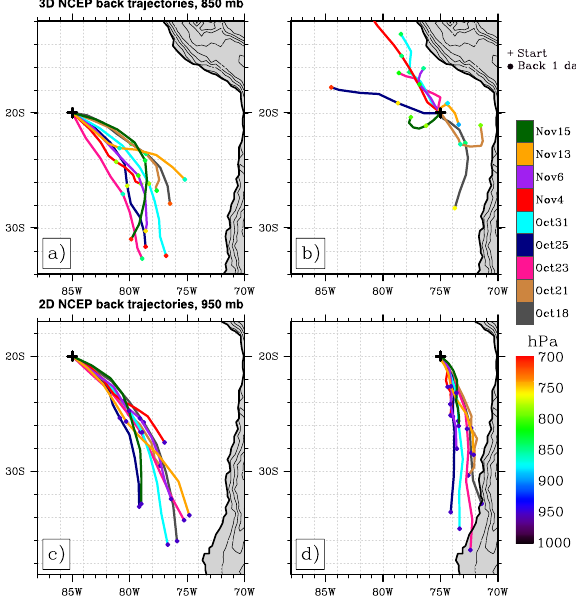
Fig. 9. FNL back-trajectories from 85 ◦ W (left) and 75 ◦ W (right) for the C130 20 ◦ S mission segments, color-coded by flight. Top panels (a) and (b) show three-dimensional “free-tropospheric” back-trajectories from 850hPa (dot shading indicates pressure along the trajectory back one and two days), and bottom panels (c) and (d) show horizontal “boundary-layer” back-trajectories using 950hPa winds. Back-trajectories are initialized at 12:00UTC for the night flights and 15:00UTC for the day flights.